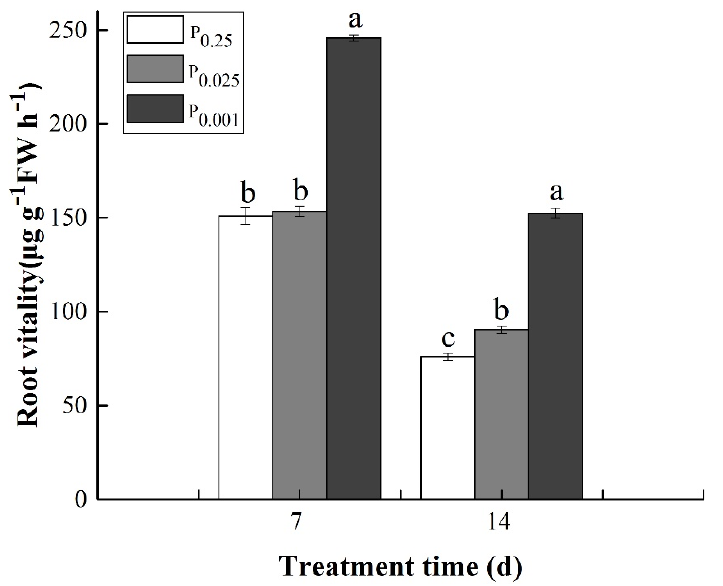
Figure 5. Root vitality under low-Pi stress. The error bars indicate the SD ( n = 3). The lowercase letters indicate the significant differences in the parameter, at the same treatment time, among the treatments using one-way ANOVA with Tukey’s test ( p < 0.05).